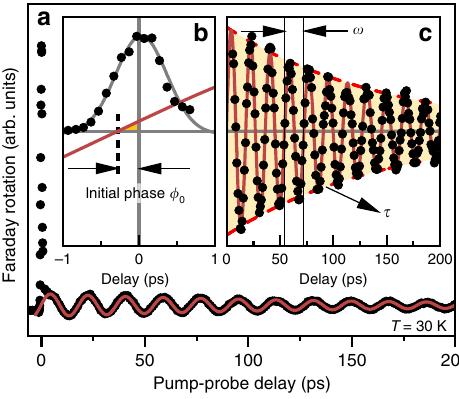
optical excitation with a circularly polarised pump pulse at 30 K.